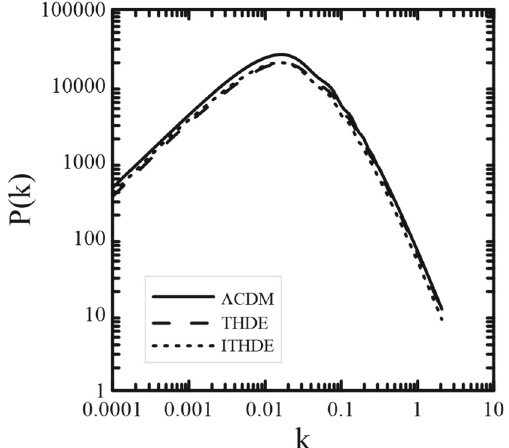
Fig. 10 The matter power spectrum of interacting and non-interacting THDE models with consideration of the future event horizon as IR cutoff compared to the (cid:2) CDM according to the best fitted values listed in Table 1. Both interacting and non-interacting THDE models show a considerable suppressing of matter power spectrum at large scale or small k -modes (cid:12) or large angle scales. This squeezing can also be seen